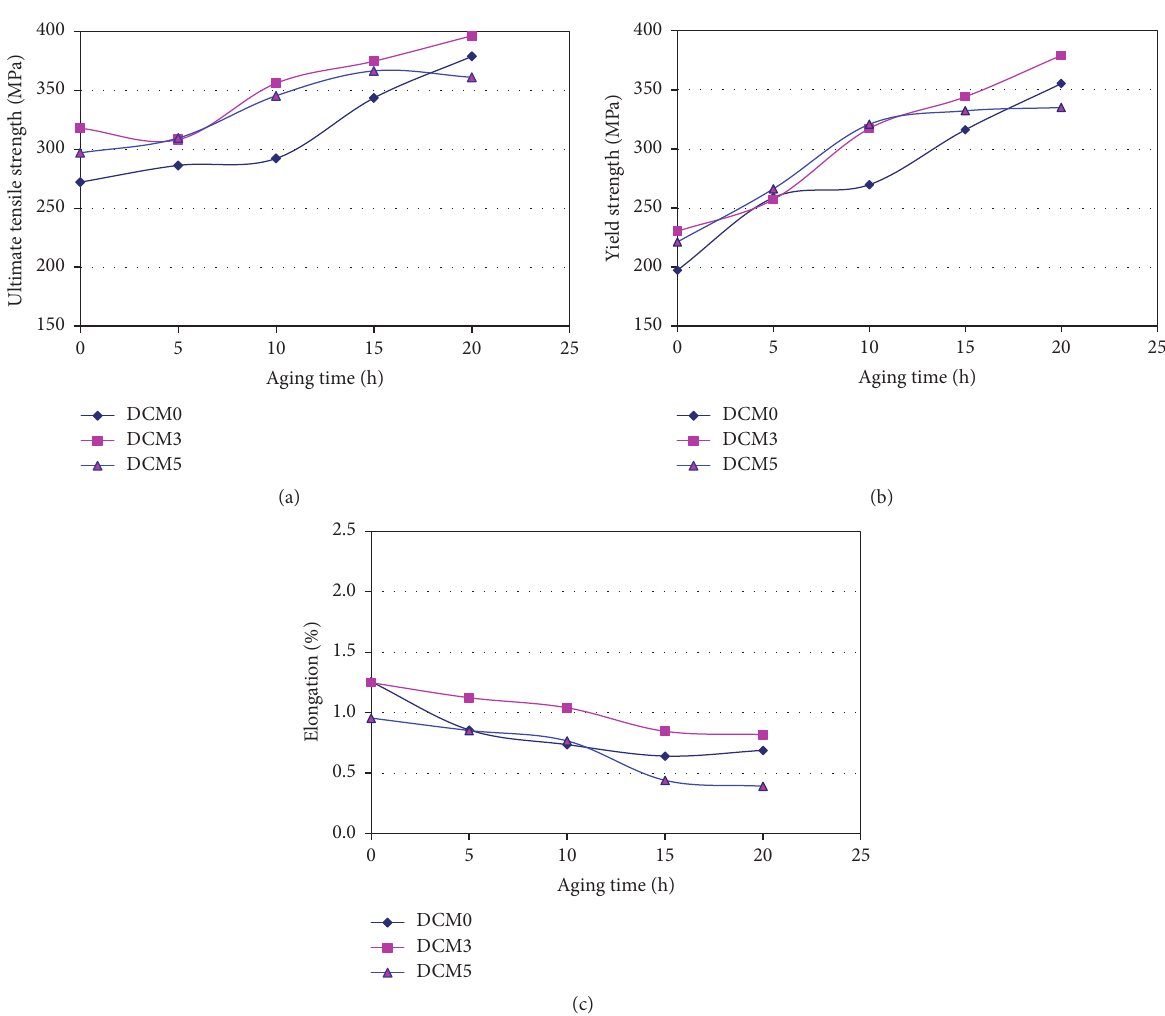
Figure 6: Variation in the alloy tensile properties as a function of aging time at 155 ∘ C: (a) UTS, (b) YS, and (c) % El.